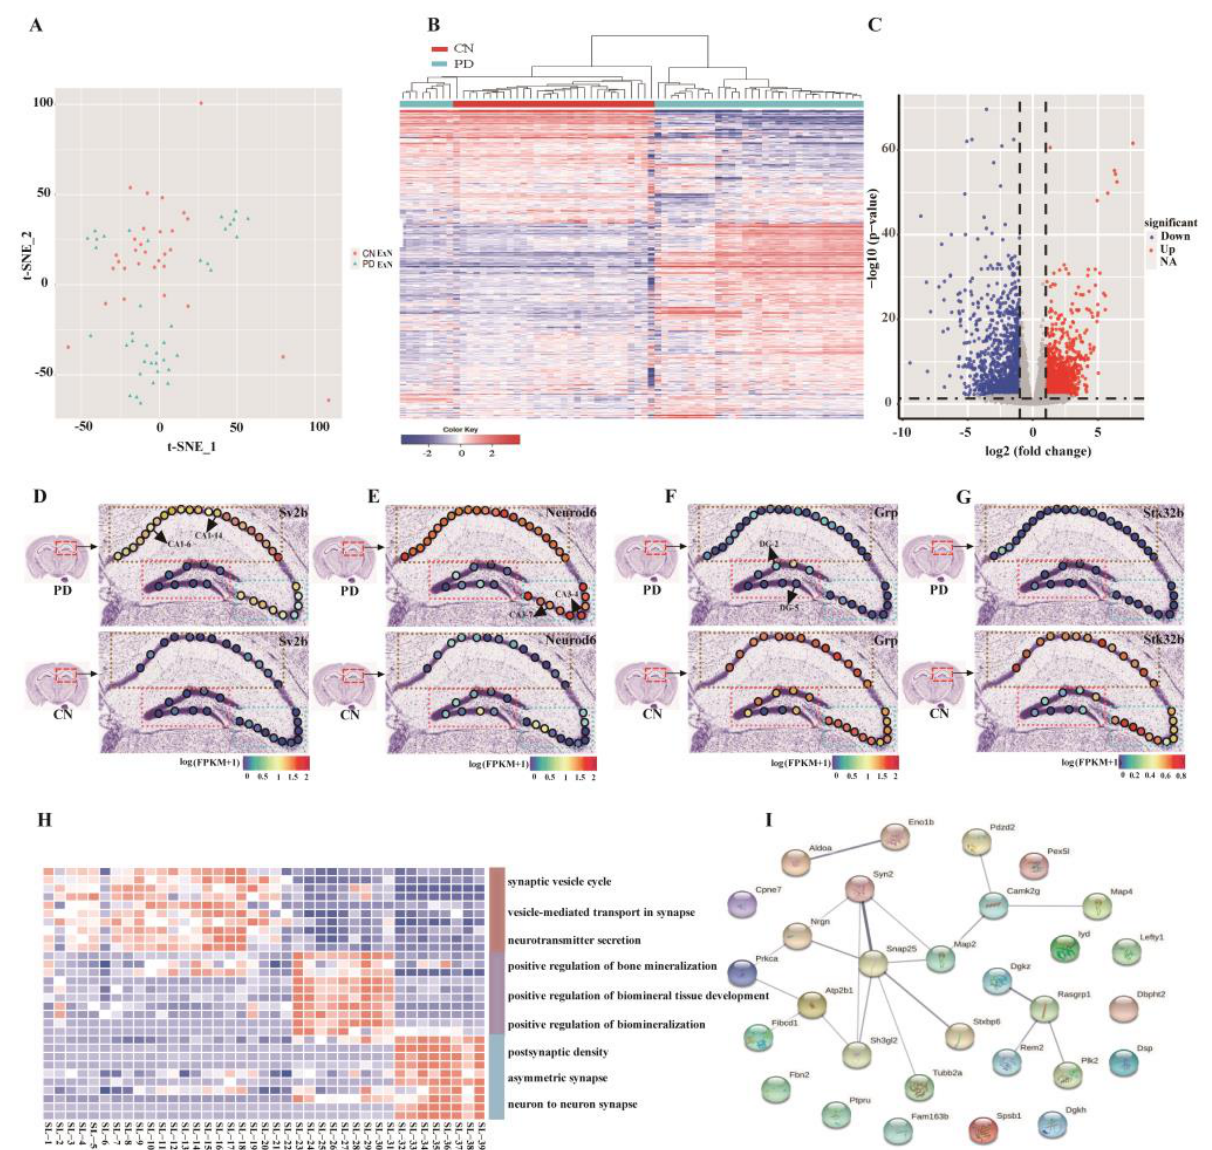
Figure 2. Cell type identification and differential expression analysis. ( A ) Gene expression profiles of single-cell microregion samples in the control group and PD group. ( B ) Single-cell type identification. ( C ) Volcano plot of differential expression of single-cell microregion samples in CN and PD group. ( D – G ) showed the expression of Sv2b , Neurod6 , Grp and Stk32b genes in different spatial locations, respectively. ( H ) Gene expression profiling of the top 10 specific marker genes at different spatial locations. ( I ) Network plot showing marker genes of different spatial locations in the